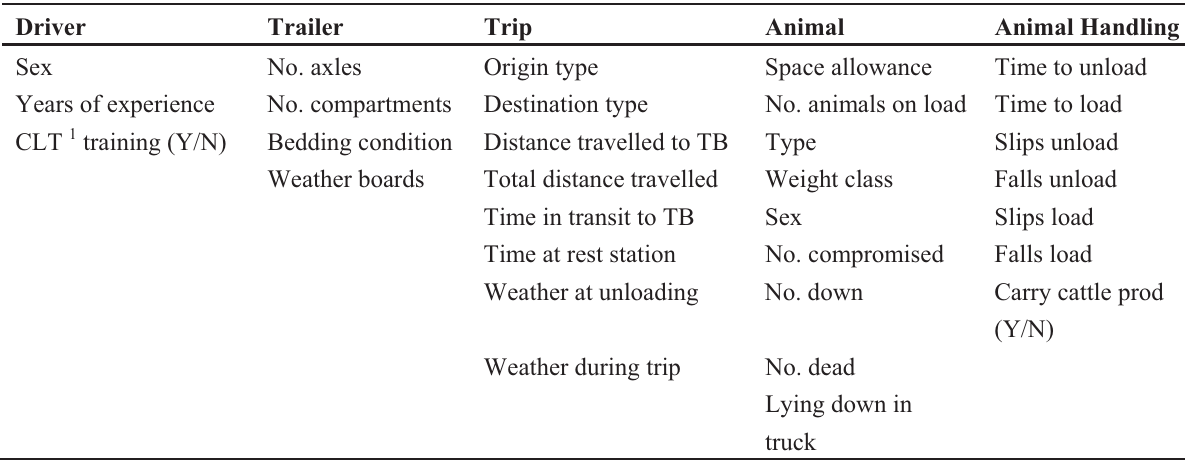
observing the unloading and reloading of cattle from trucks stopped for feed, water and rest near Thunder Bay, ON